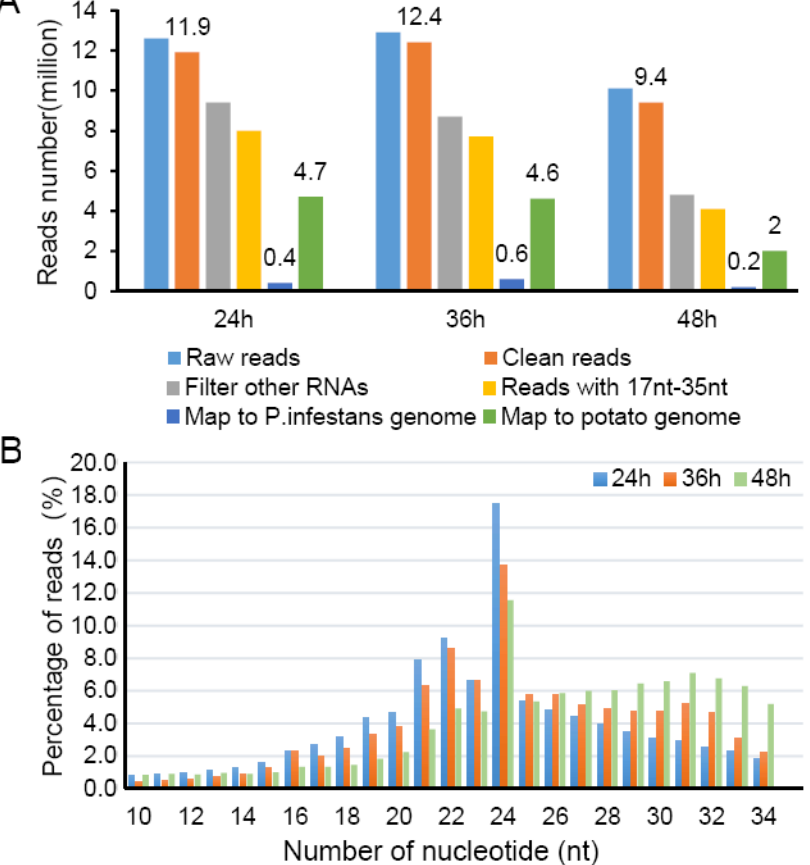
Figure 1. Summary of basic information of the sRNA-seq data. ( A ) sRNA reads distribution at different time points after inoculation with P. infestans . ( B ) Length distribution of clean sRNA reads. The x-axis shows the sRNA sequence sizes, from 10 to 34 nt; the y-axis shows the percentage of reads for every given size. Bars with different colors show different time points.